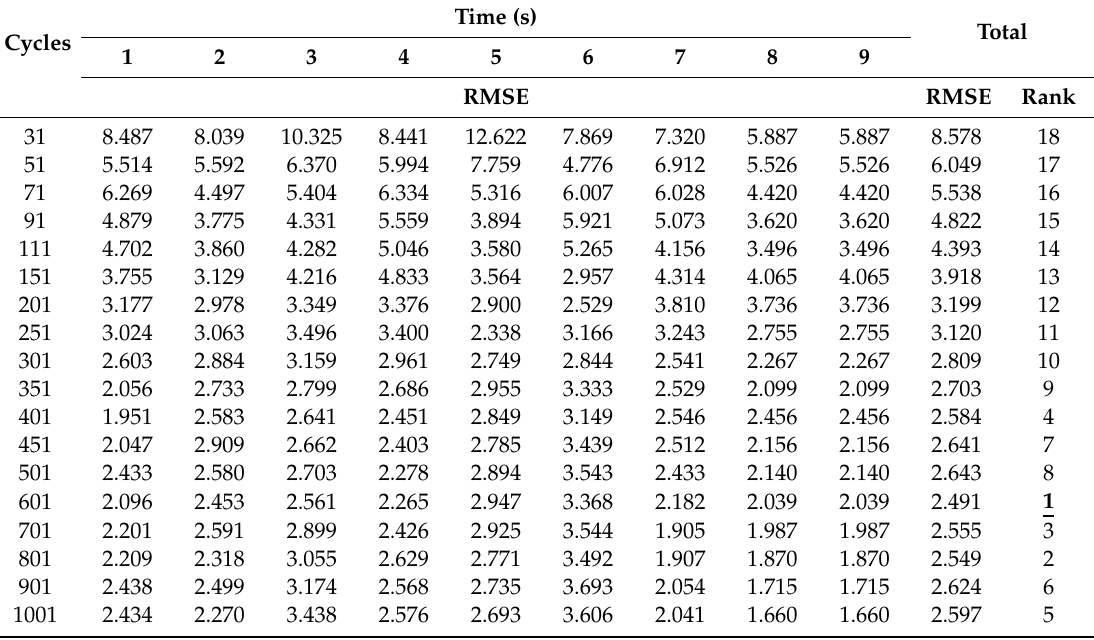
Table 5. Results of root mean square error (RMSE) analysis between T Thc and T Rec for 18 candidate